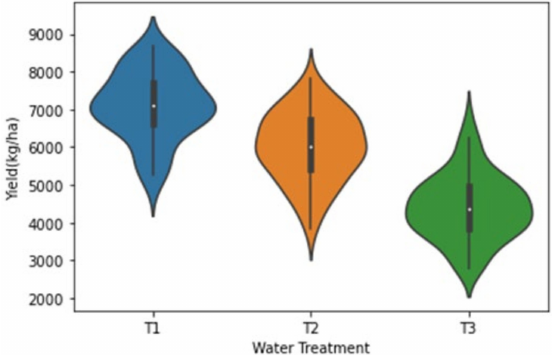
Figure 7. Yield distribution with different amounts of irrigation.